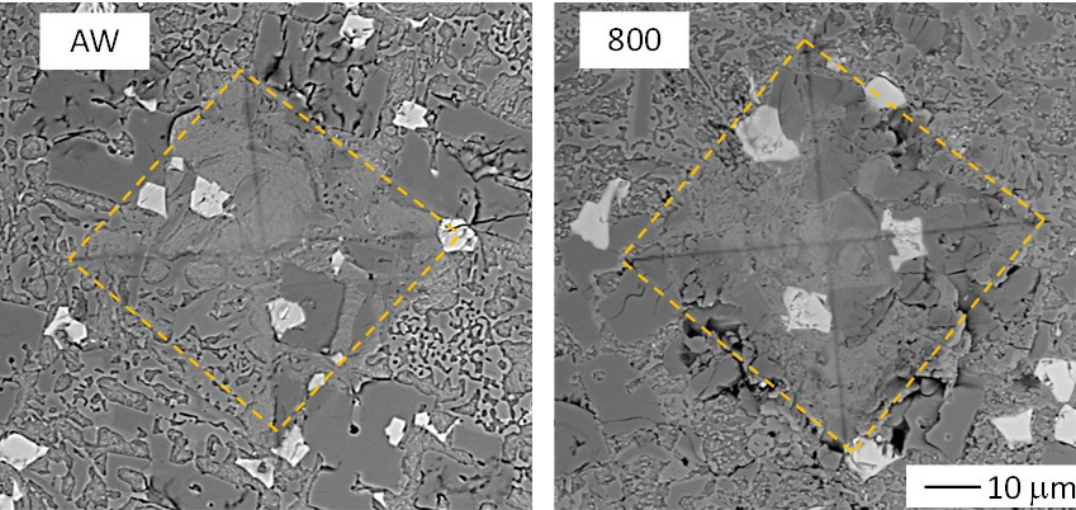
Figure 9. SEM-BS images of HV2 hardness imprints for AW and